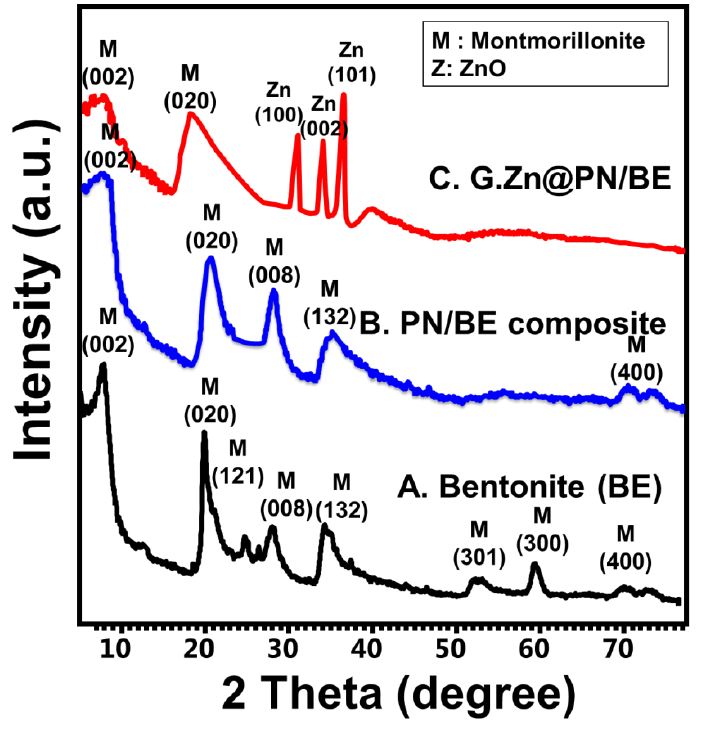
Figure 1. XRD patterns of raw bentonite (BE) ( A ), polyaniline/bentonite composite (PN/BE) ( B ), and the synthetic G.Zn@PN/BE green composite ( C ).